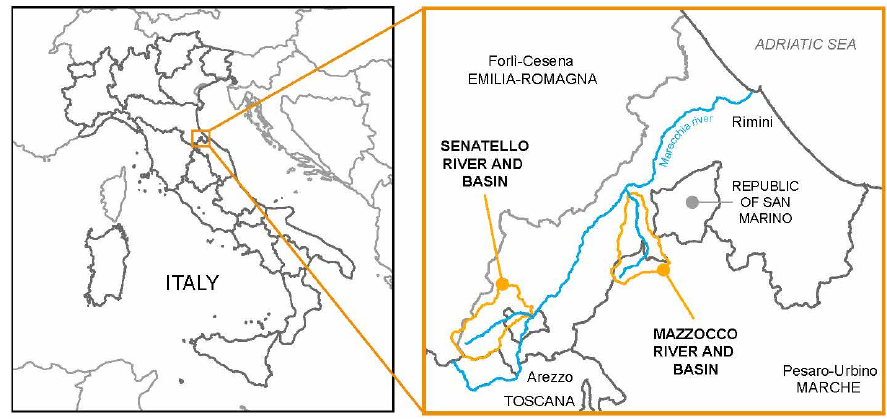
Figure 1. Location map of Mazzocco and Senatello river basins.